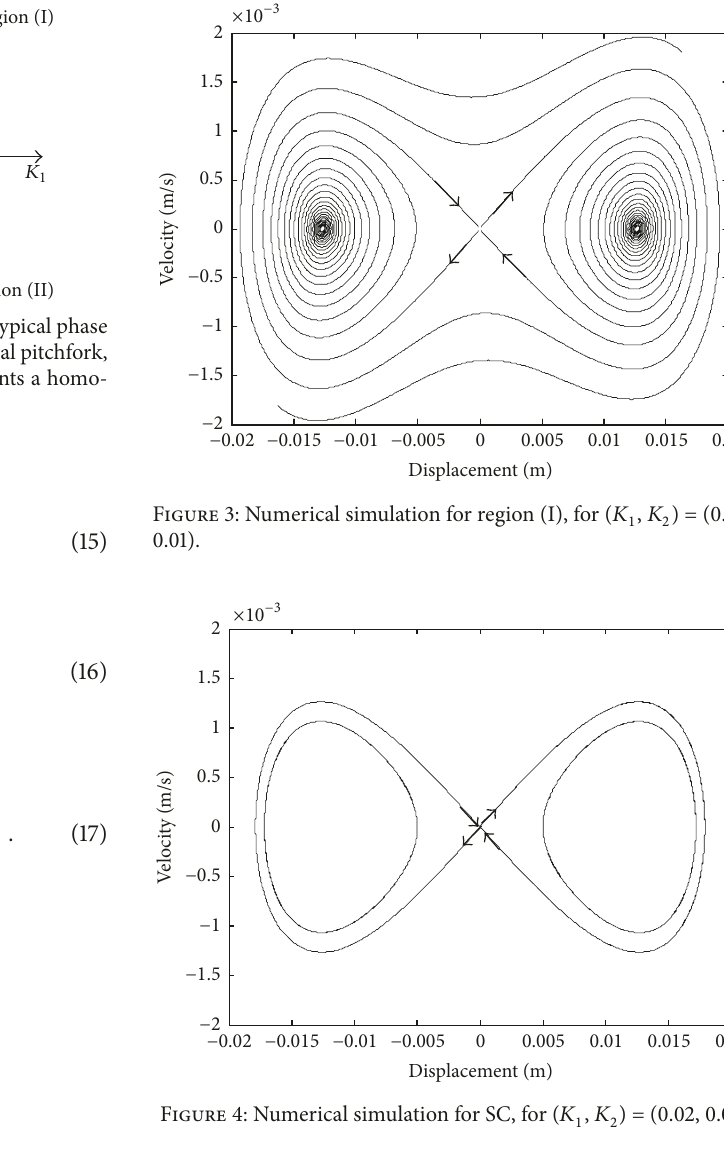
package DIVPRK of IMSL in the FORTRAN subroutines